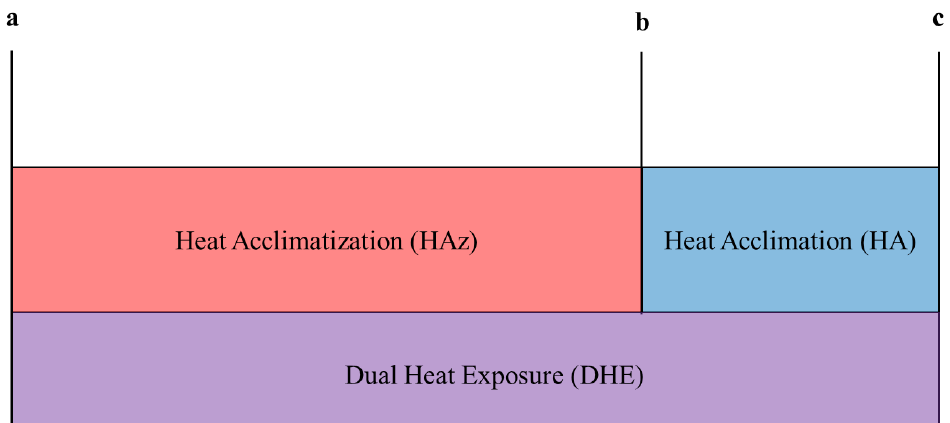
Figure 1. Self-directed summer training (HAz) and laboratory-based (HA) heat induction methods were used in sequence to assess the effects of each independent and together (DHE, HAz plus HA). Time points at which data were collected ( a – c ) represent different baseline, pre-, and post-values for isolating aspects of our protocol: ( a ) represents the baseline test for the entire study and represents pre-HAz and pre-DHE, ( b ) represents post-HAz and pre-HA, and ( c ) represents post-HA and post-DHE. ∆ change for each induction method (HAz, HA, or DHE) was calculated as follows for the decision-tree analysis: (1) HAz adaptations = b − a, (2) HA adaptations = c − b, and (3) DHE adaptations = c − a.